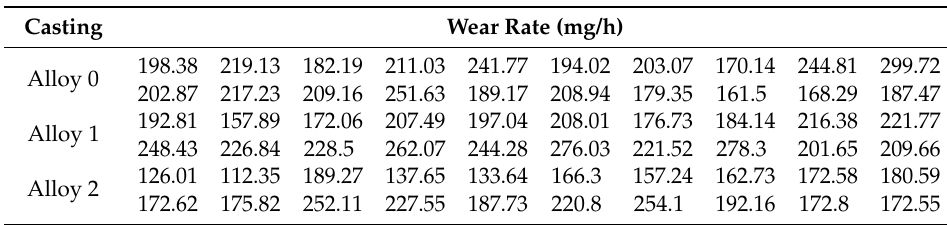
Table 2. Wear rates in service.